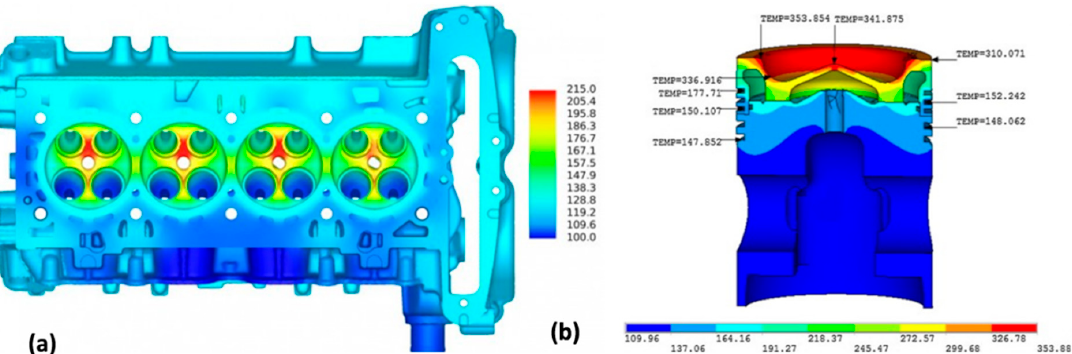
Figure 20. Computer simulation of temperature distribution within a combustion engine block with maximum temperature reaching 215 °C ( a ) [2,81] and thermal fields of a diesel engine piston with maximum temperature exceeding 350 °C ( b ) [82].